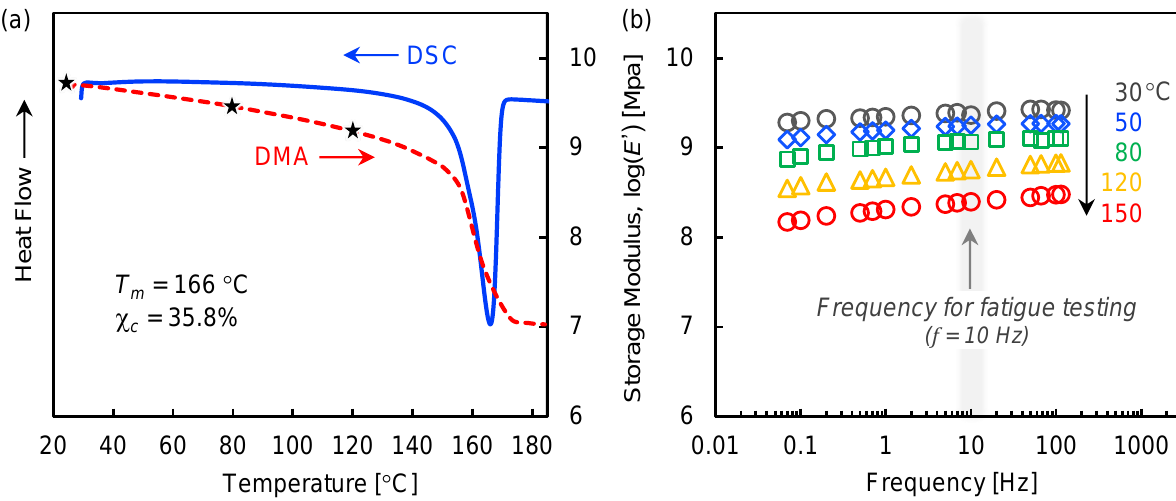
Figure 2. ( a ) Thermal properties of a m-PP matrix and BFPP measured by DSC and DMA, and ( b ) frequency dependence of the storage modulus of BFPP measured by DMA.